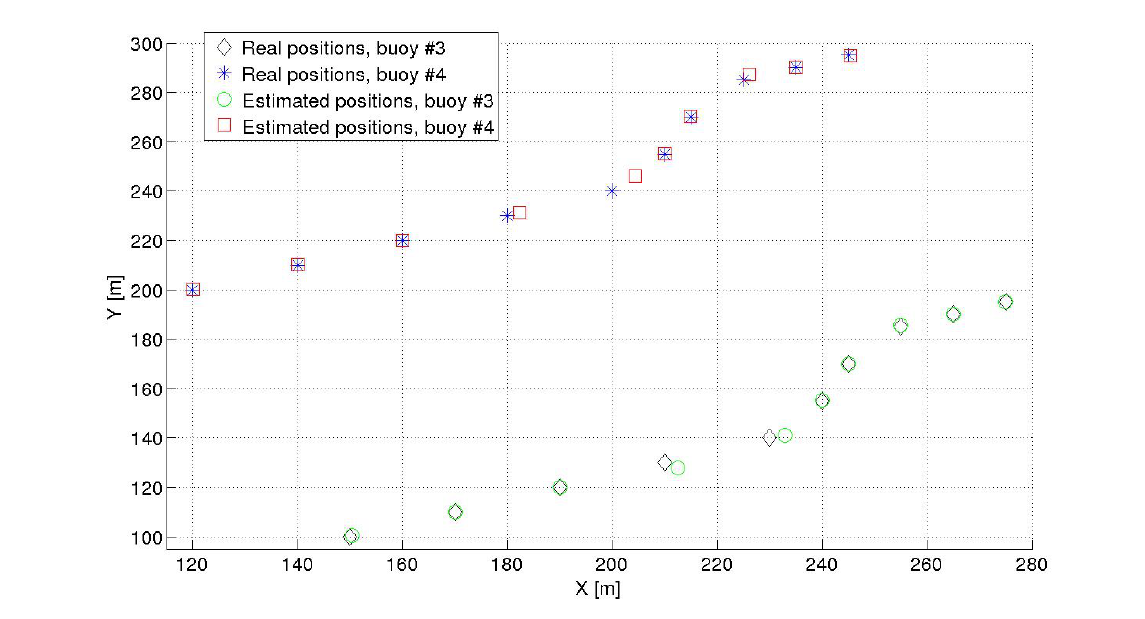
Figure 7. Buoys 3 and 4 movement due to a surface current.